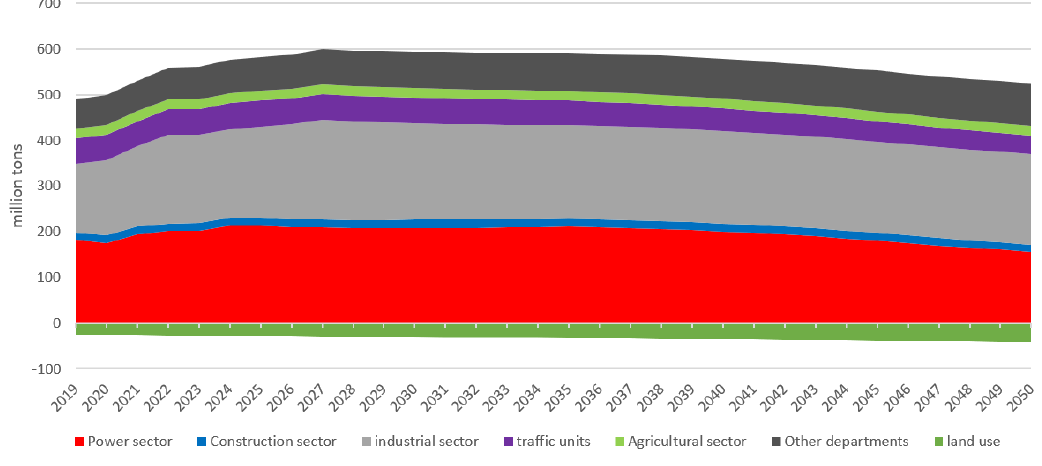
Figure 9. Changes in CO 2 emissions in Zhejiang Province under the carbon pricing scenario.